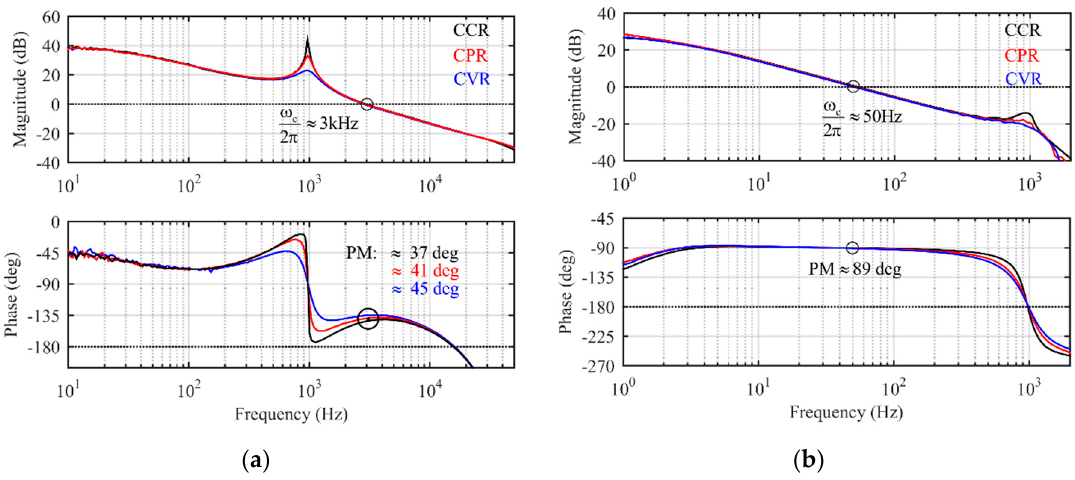
Figure 7. The measured input-voltage feedback-loop gains of the boost-power-stage converter under ( a ) integral (I) control, and ( b ) proportional-integral-derivative (PID) control in the different regions of the PVG.